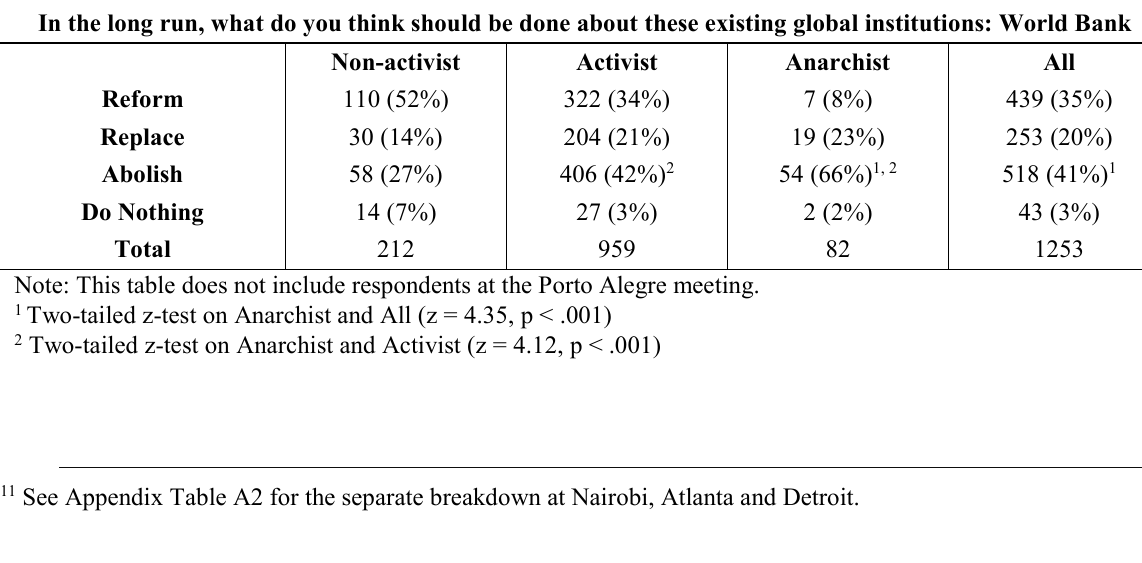
Table 5: Attitudes toward the World Bank